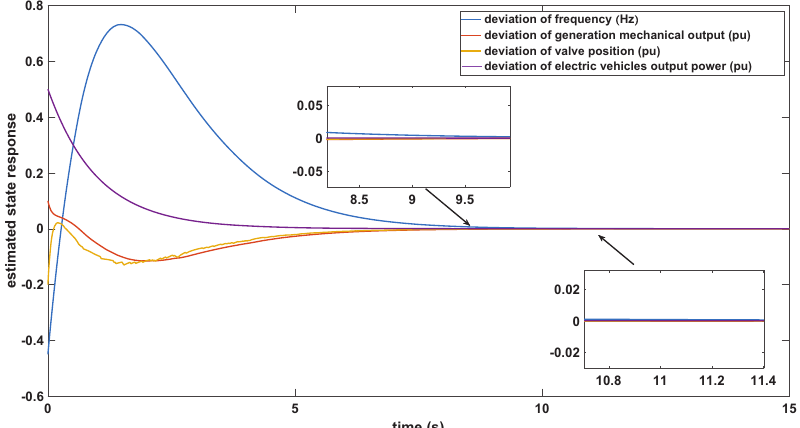
Figure 7. Observation trajectory of one-area power system.